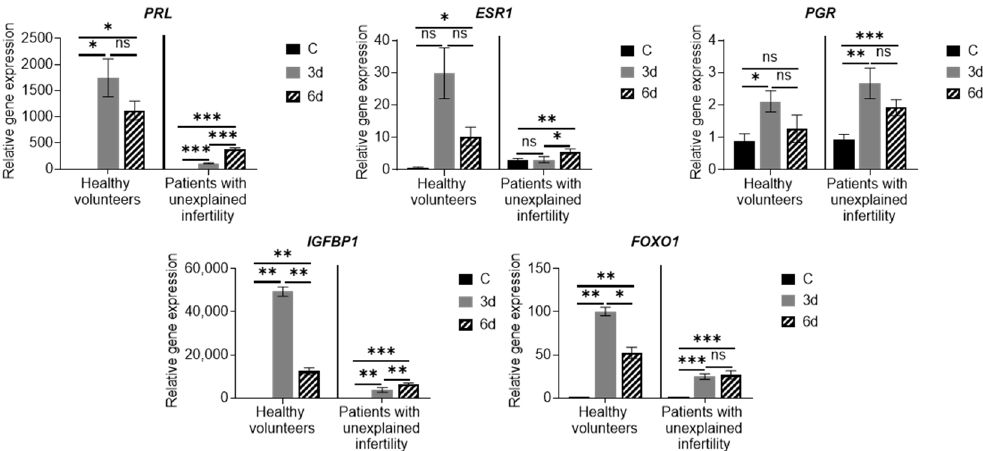
Figure 4. Expression of genes inherent in decidualization. Results are presented as mean ± standard deviation. In the group of healthy volunteers n = 2, in patients with unexplained infertility n = 4. C—control cells, 3d—cells after 3 days of culture in decidualization medium, 6d—cells after 6 days in differentiation medium. * p ≤ 0.05; ** p ≤ 0.01; *** p ≤ 0.001, ns—not statistically significant, based on t -test (Holm–Sidak method).